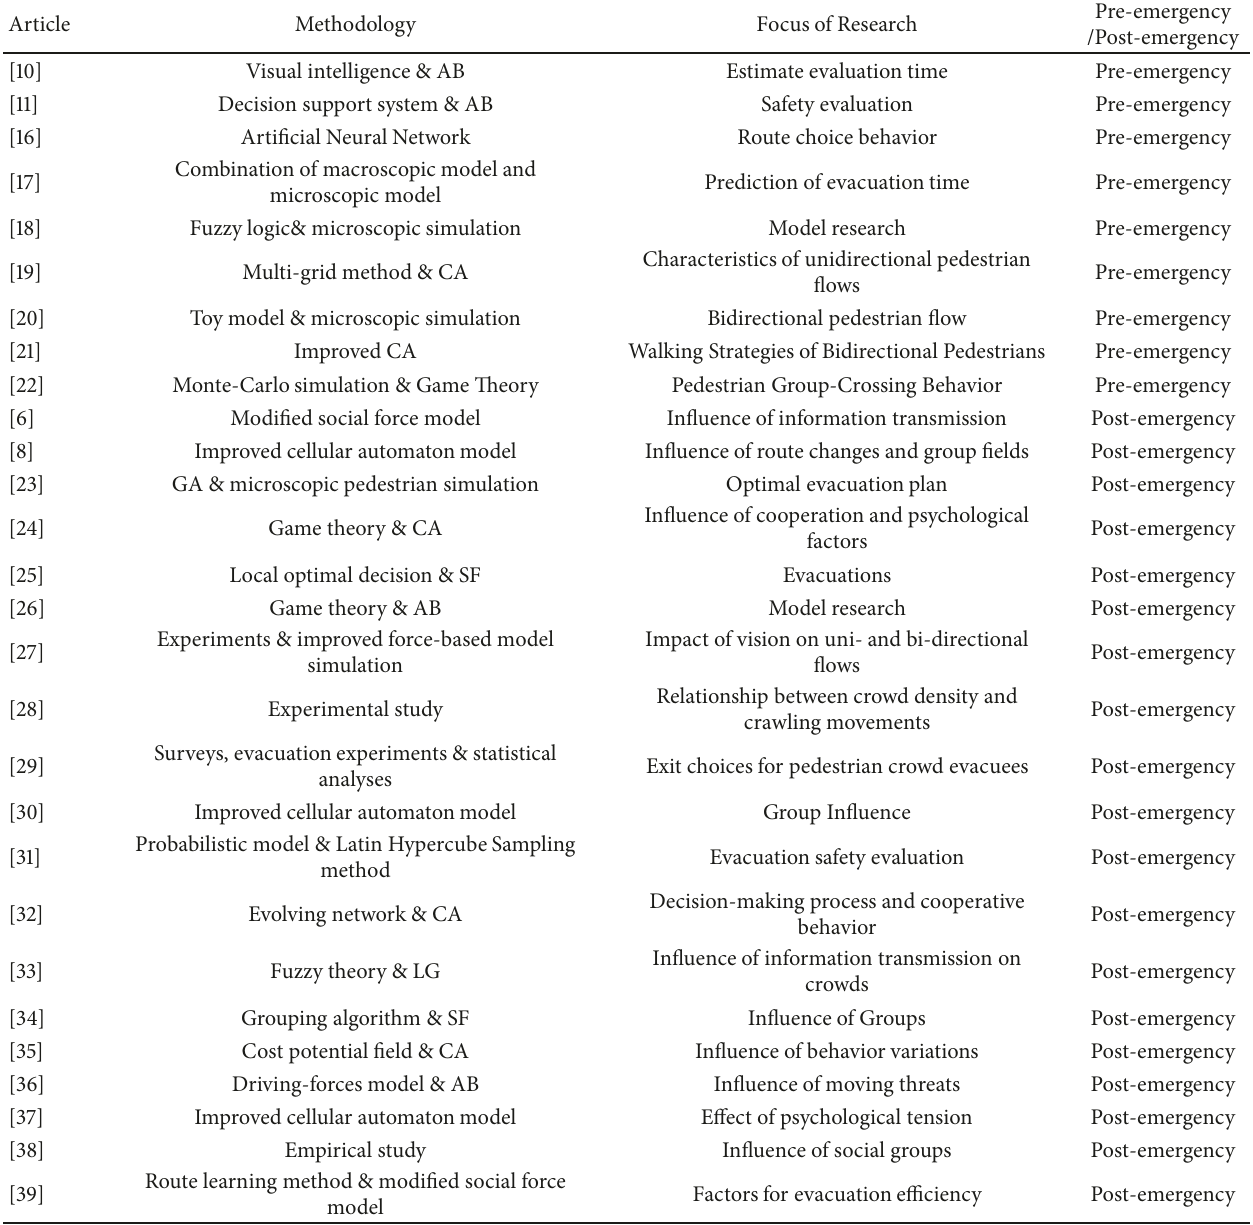
Table 1: Brief summary of recent studies on pedestrian